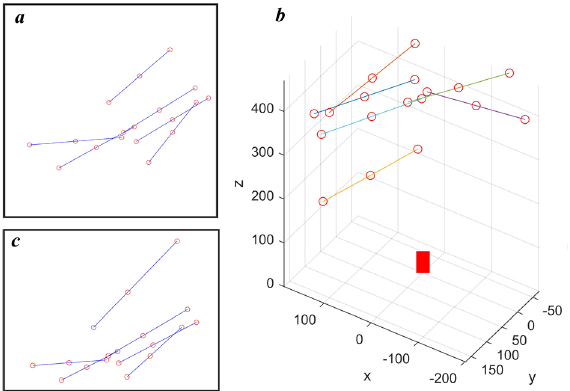
Figure 3. Generating data for calibration and verification in the simulation environment. ( a ) is the targets generated on the simulated laser plane. ( b ) shows the distribution of the targets in the 3D space. ( c ) is the image of the targets.